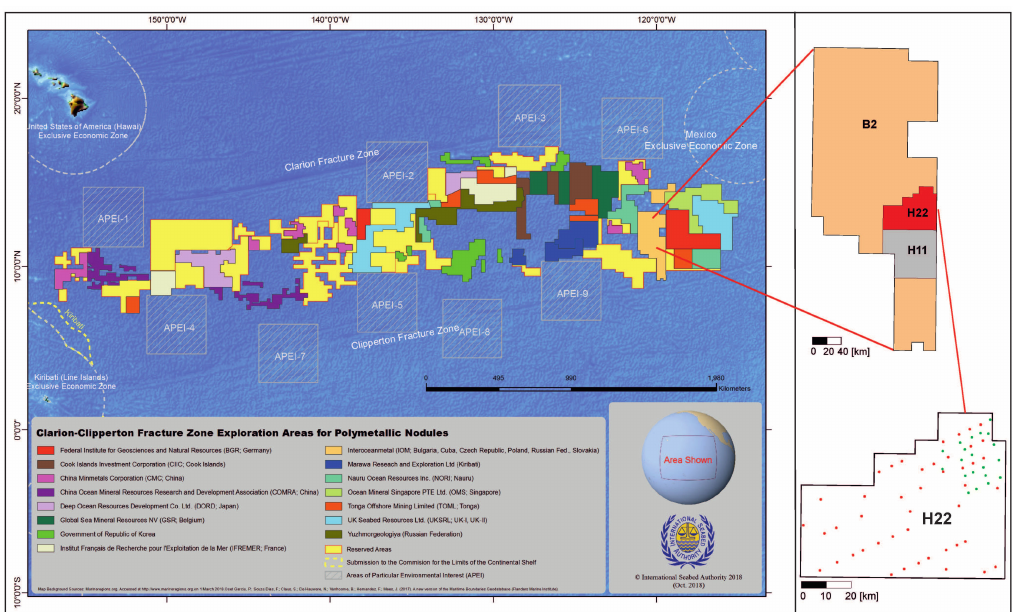
Figure 1. Location of B2 Interoceanmetal Joint Organization (IOM) area and H22 and H11 exploration blocks against the background of Clarion–Clipperton Zone Exploration Areas for Polymetallic Nodules [45]; location of box corer sampling sites and seafloor photographs in H22 exploration block (red—2014 cruise, green—2019